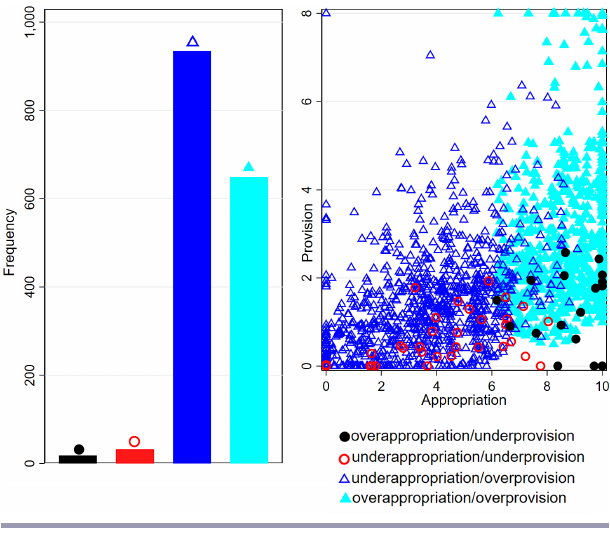
Fig. 4. Frequency distribution of four strategies played. Circles denote underprovison strategies, and triangles denote overprovision strategies. Underappropriation in combination with overprovision was the predominant strategy.